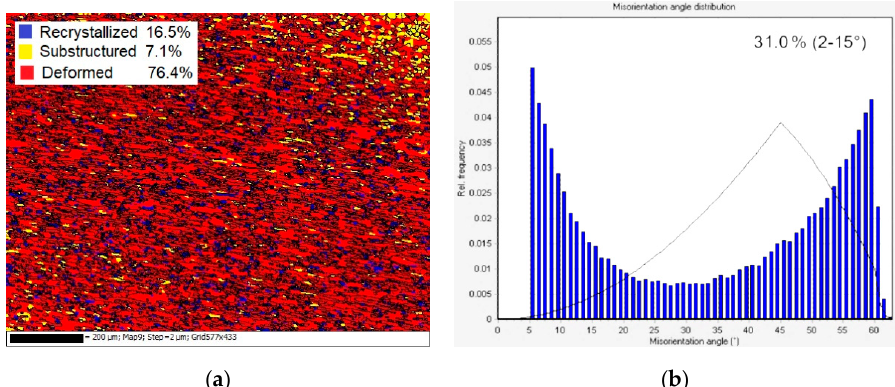
Figure 1. ( a ) Microstructure and ( b ) misorientation grain distribution of forged D2195-T6. Table 2. Mechanical properties and grain size of forged plate D2195-T6.